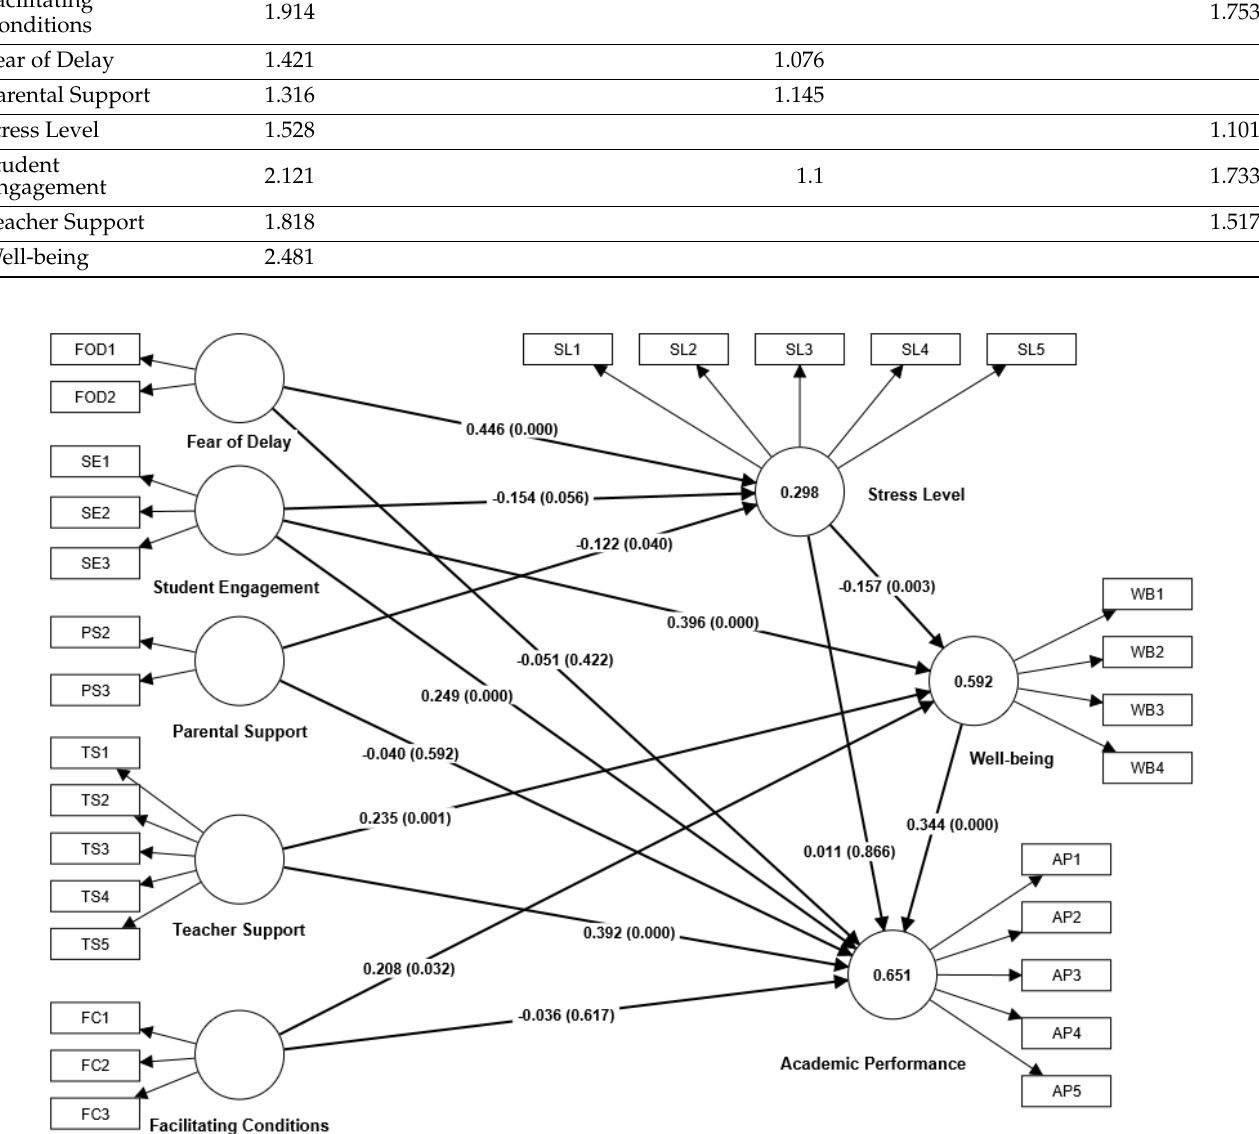
Figure 2. Structural model evaluation results with R 2 , path coefficients, and p values.